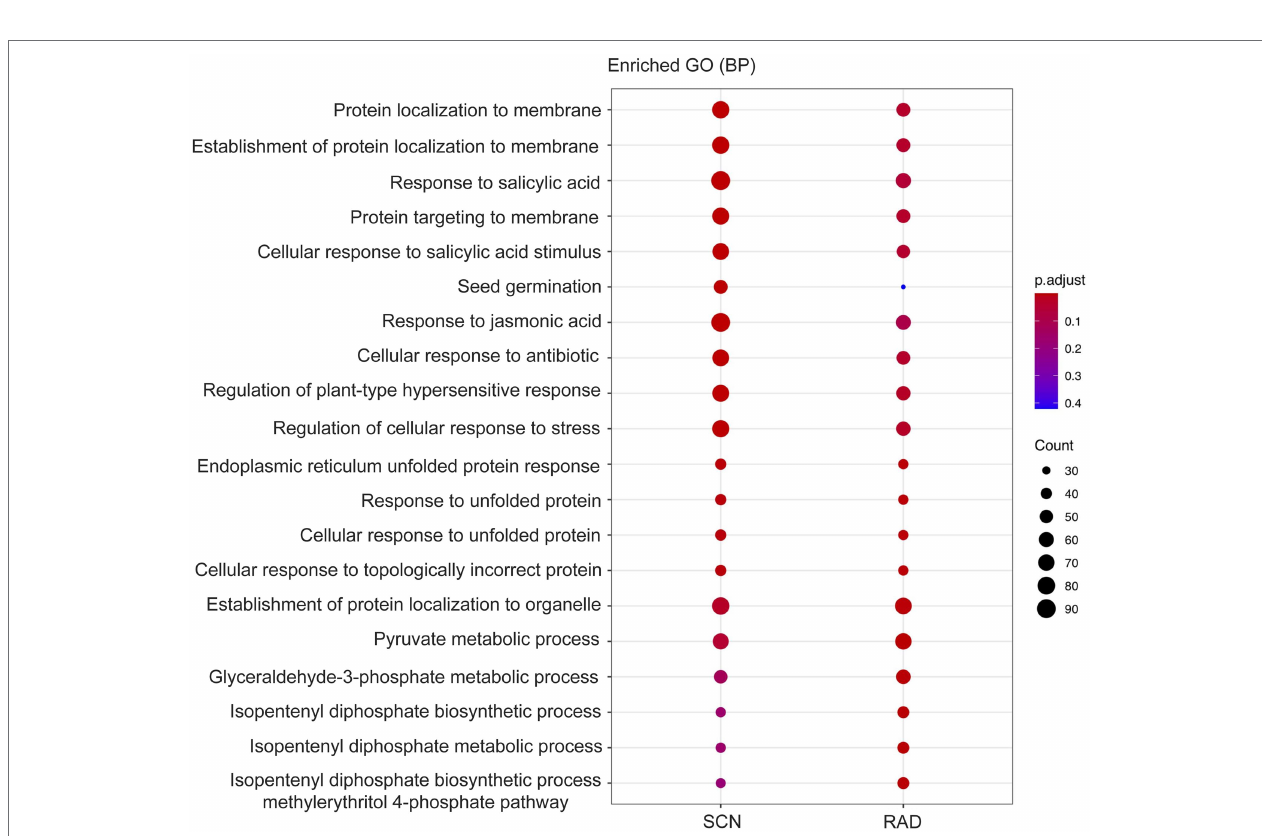
FIGURE 3 | Barplot of the number of TEs by their family found within SCN- and RAD-associated